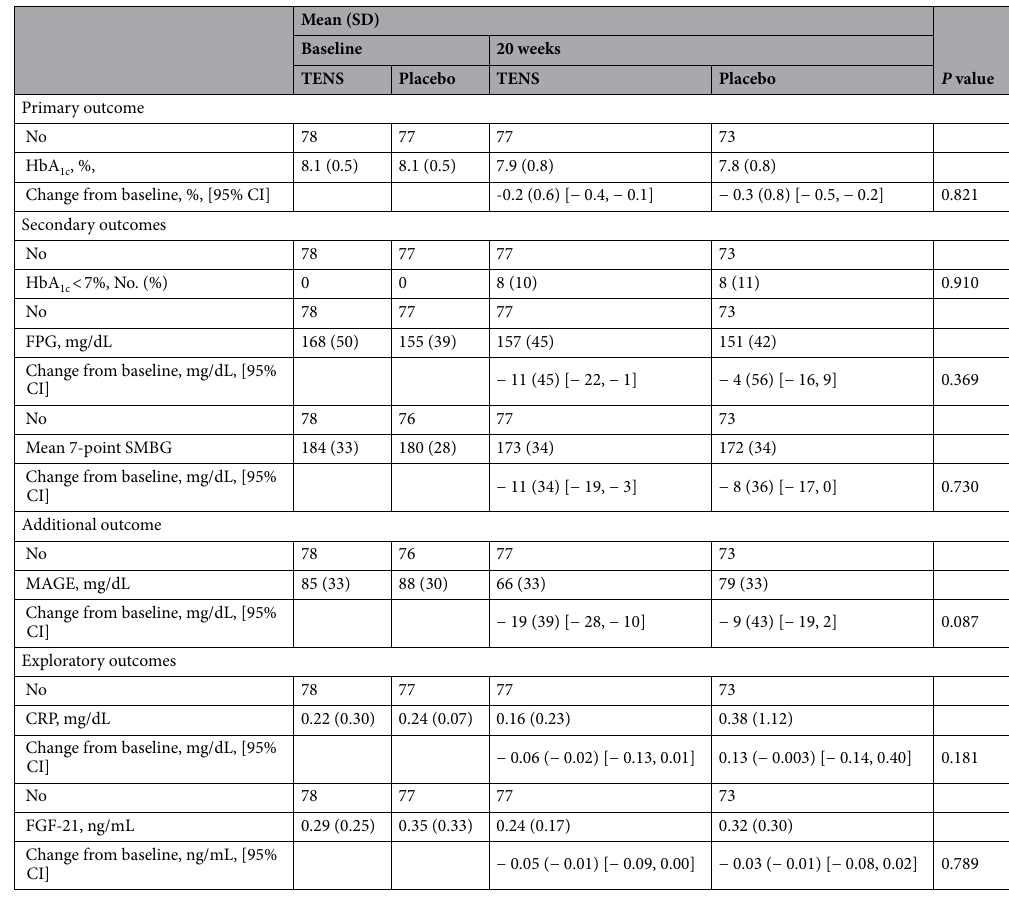
Table 2. Glycemic Outcomes. Two-sample t -test (continuous variable) or Chi-square Test (categorical variable) was conducted. If normal assumption was violated, Wilcoxon rank sum test was applied. SD standard deviation, CI confidence interval, HbA 1c glycosylated hemoglobin, FPG fasting plasma glucose, SMBG self- monitoring blood glucose, MAGE mean amplitude of glycemic excursion, CRP C-reactive protein, FGF-21 fibroblast growth